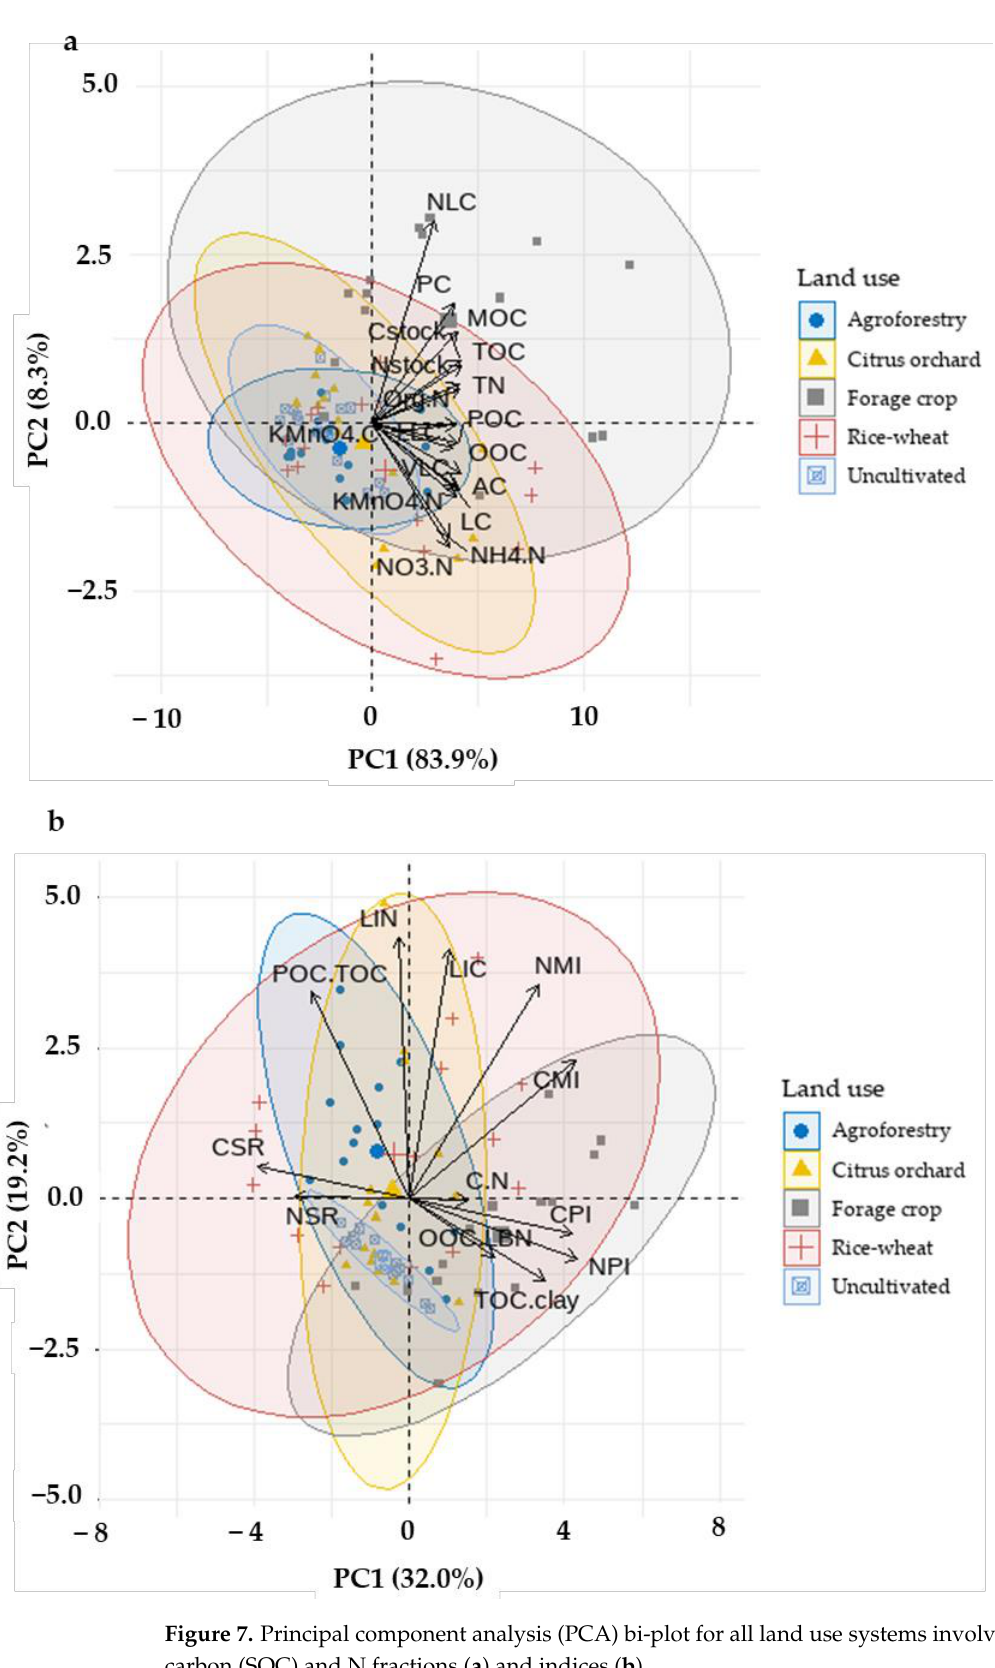
Figure 7. Principal component analysis (PCA) bi-plot for all land use systems involving soil organic carbon (SOC) and N fractions ( a ) and indices ( b ).